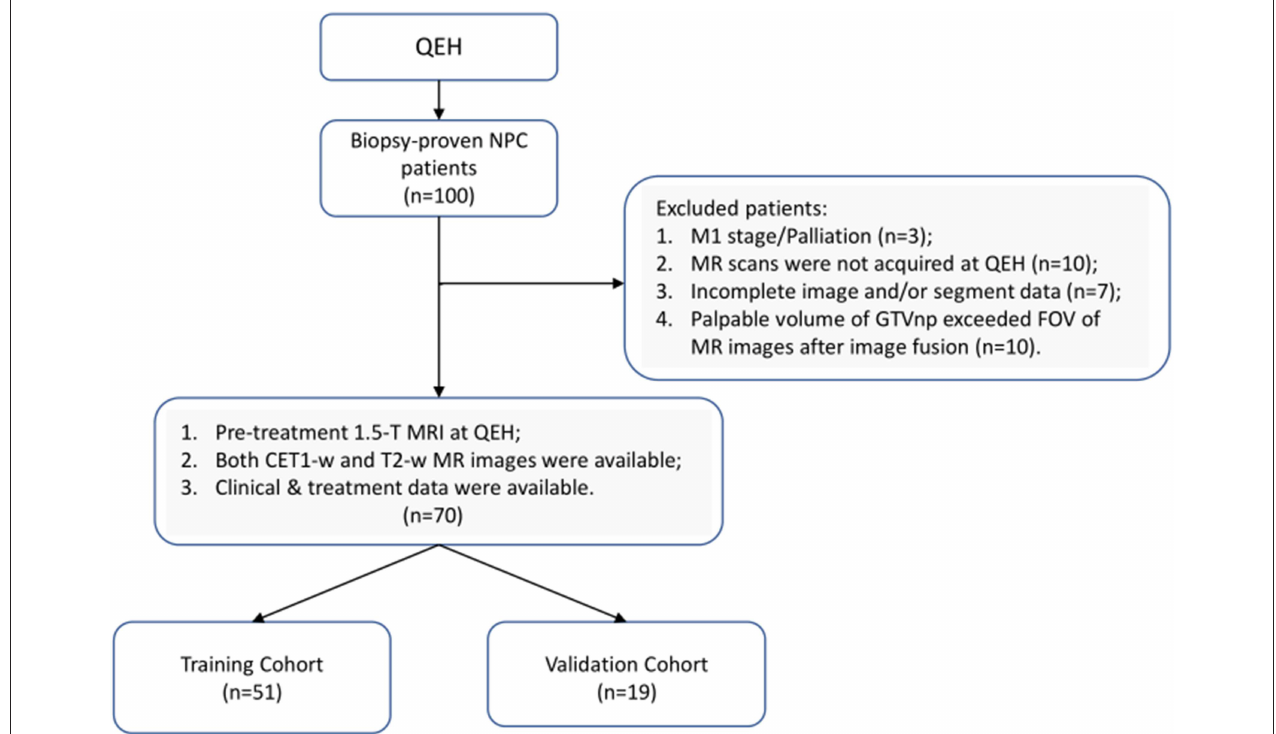
FIGURE 1 | Inclusion and exclusion criteria used in the current study.